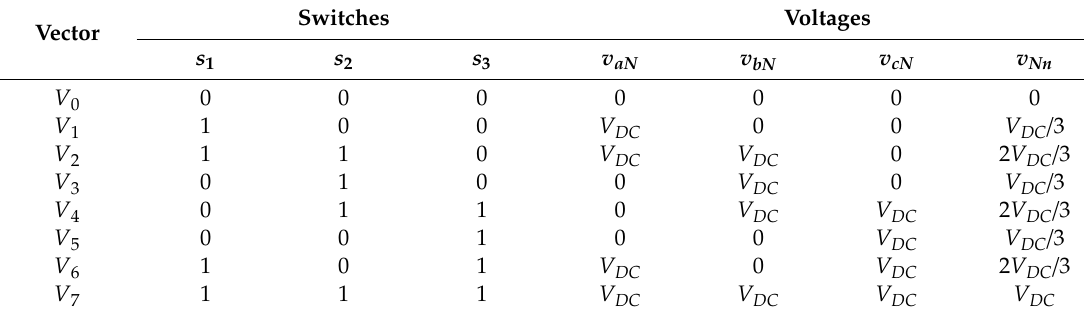
Table 5. Vectors and voltages of the three-phase VSI.